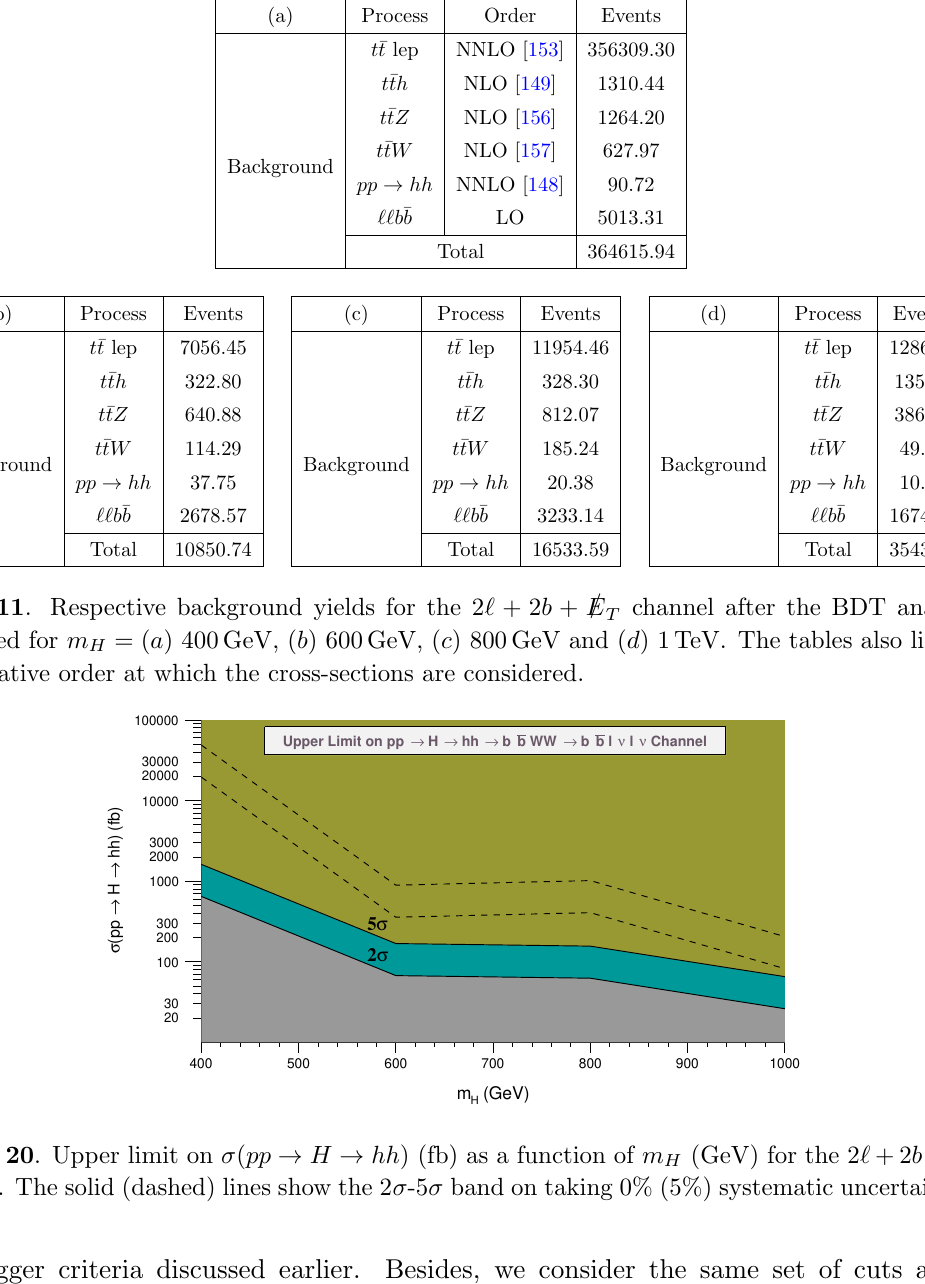
H hh ) (fb) as a function of m H (GeV) for the 2 ‘ + 2 b + =E T ! !